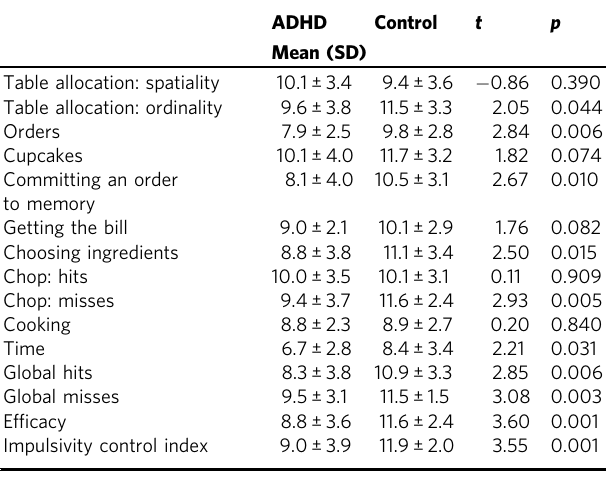
Table allocation: